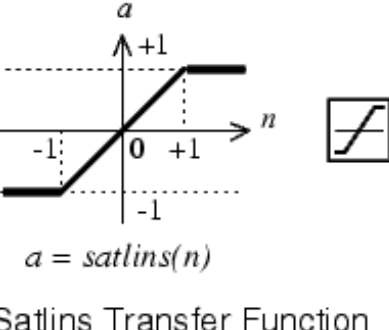
Figure 9. Saturated linear symmetric transfer